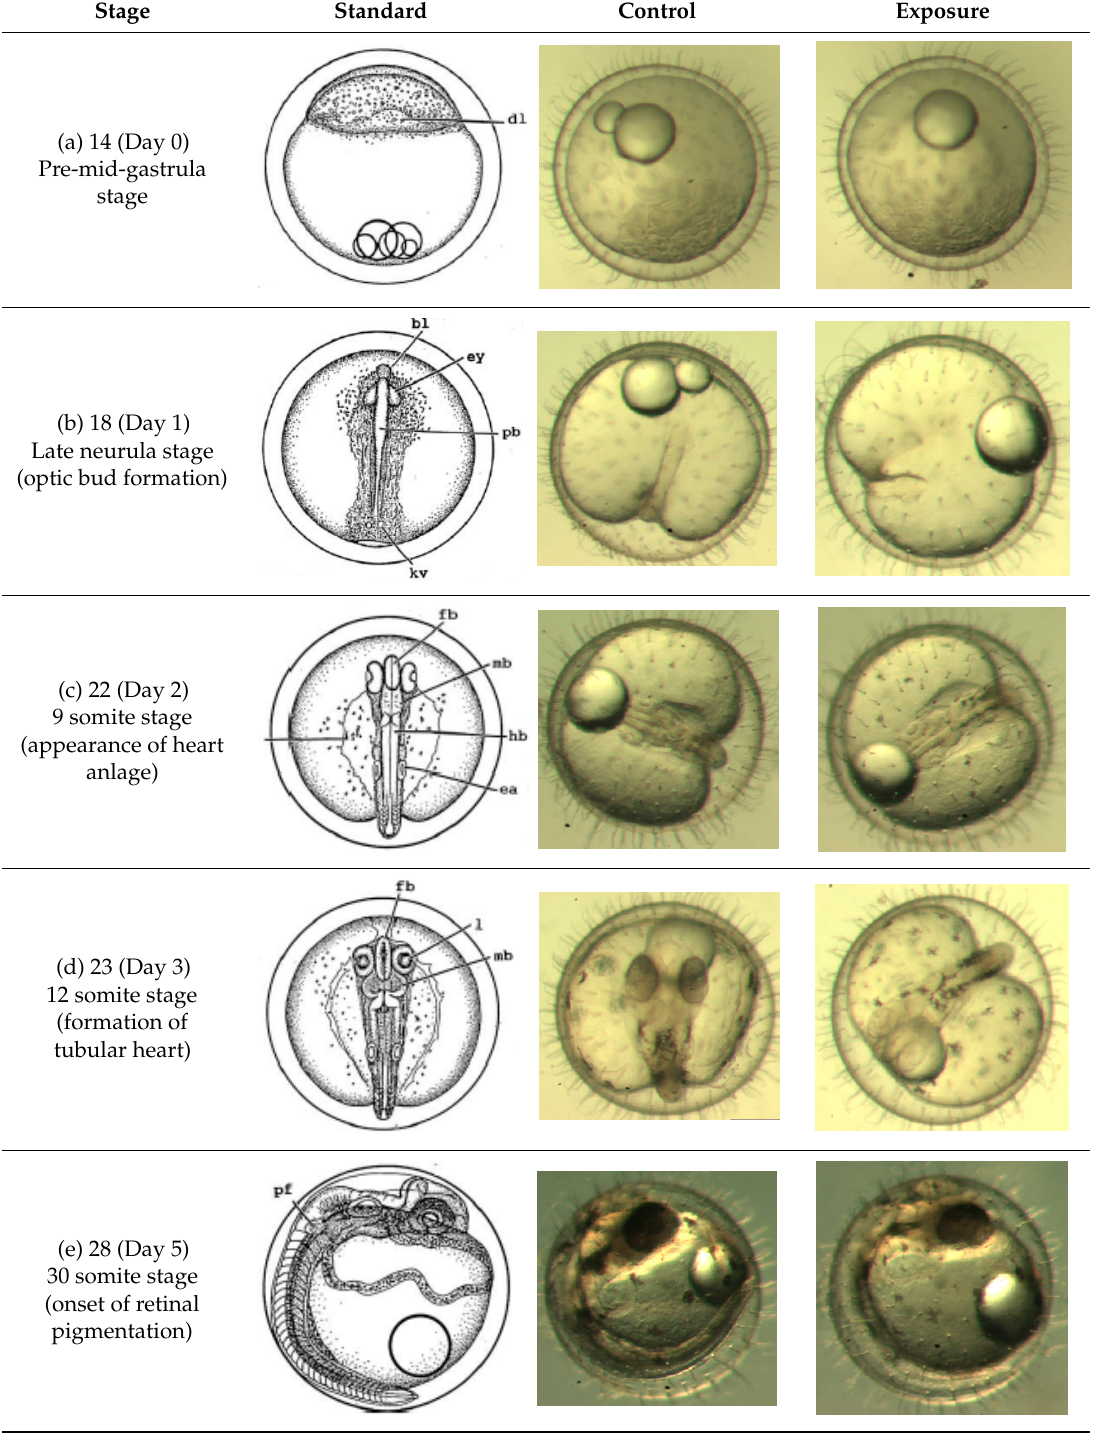
Table 2. Developmental stages of control groups and whole period exposure group (photos selected the embryo showing the typical stage [26] in the dish).